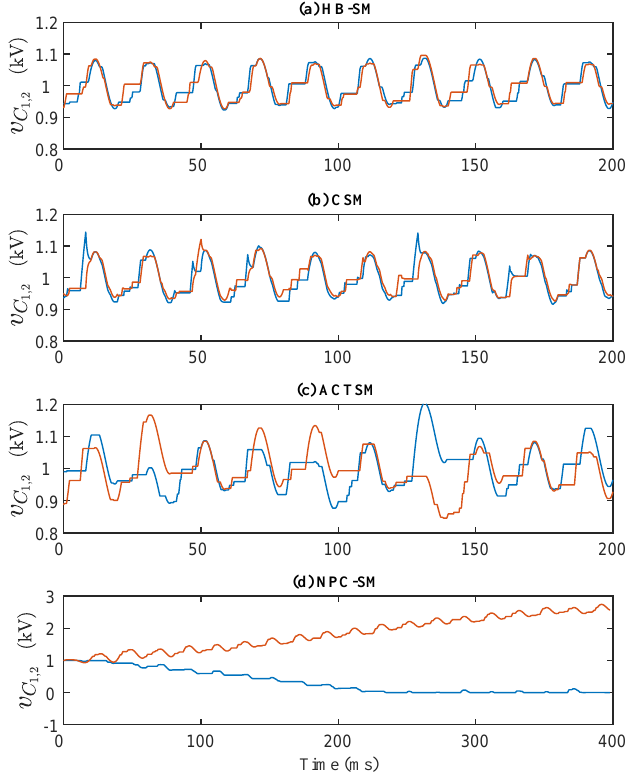
Figure 18. Capacitor voltages of selected SMs: ( a ) HB–SM, ( b ) CSM, ( c ) ACTSM, and ( d )